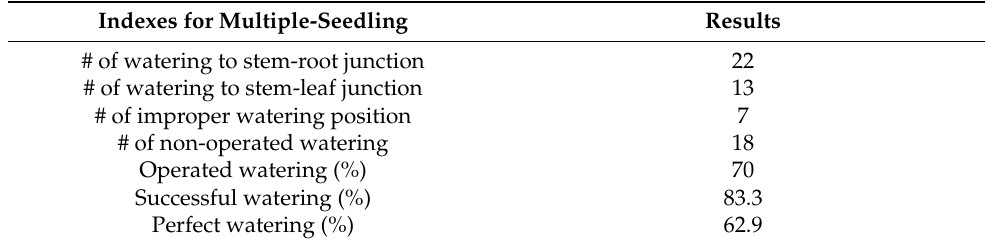
Table 3. Multiple-seedling experimental